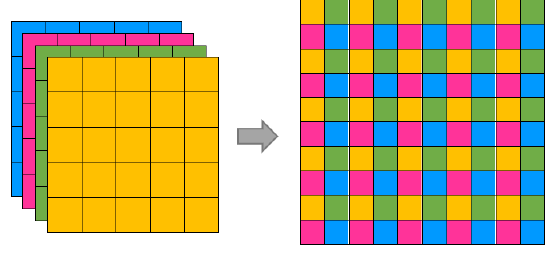
Figure 4. Schematic diagram of subpixel convolution.